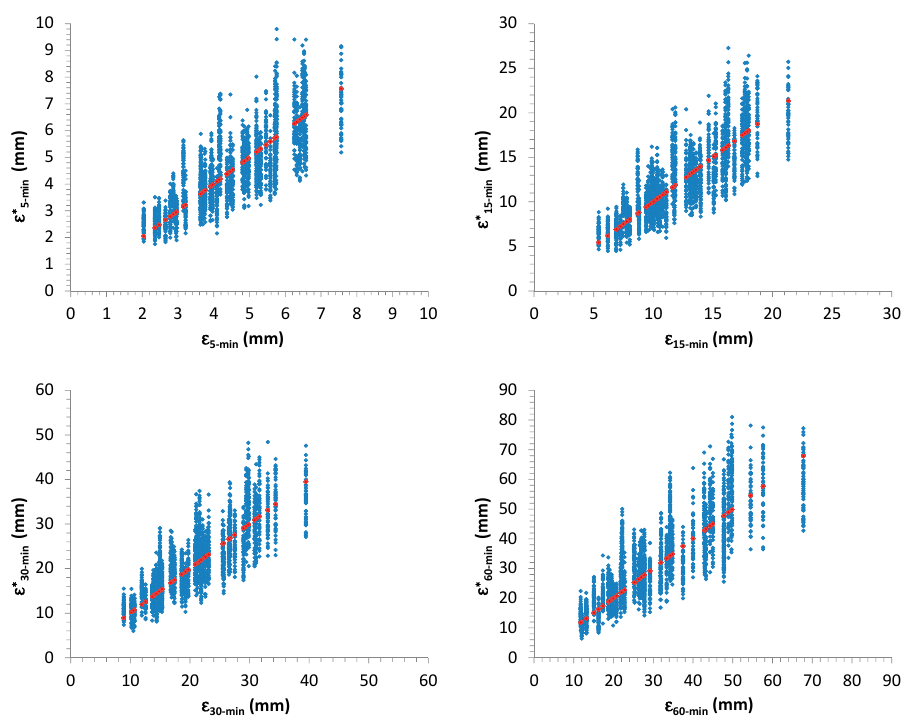
ε (horizontal axis) and